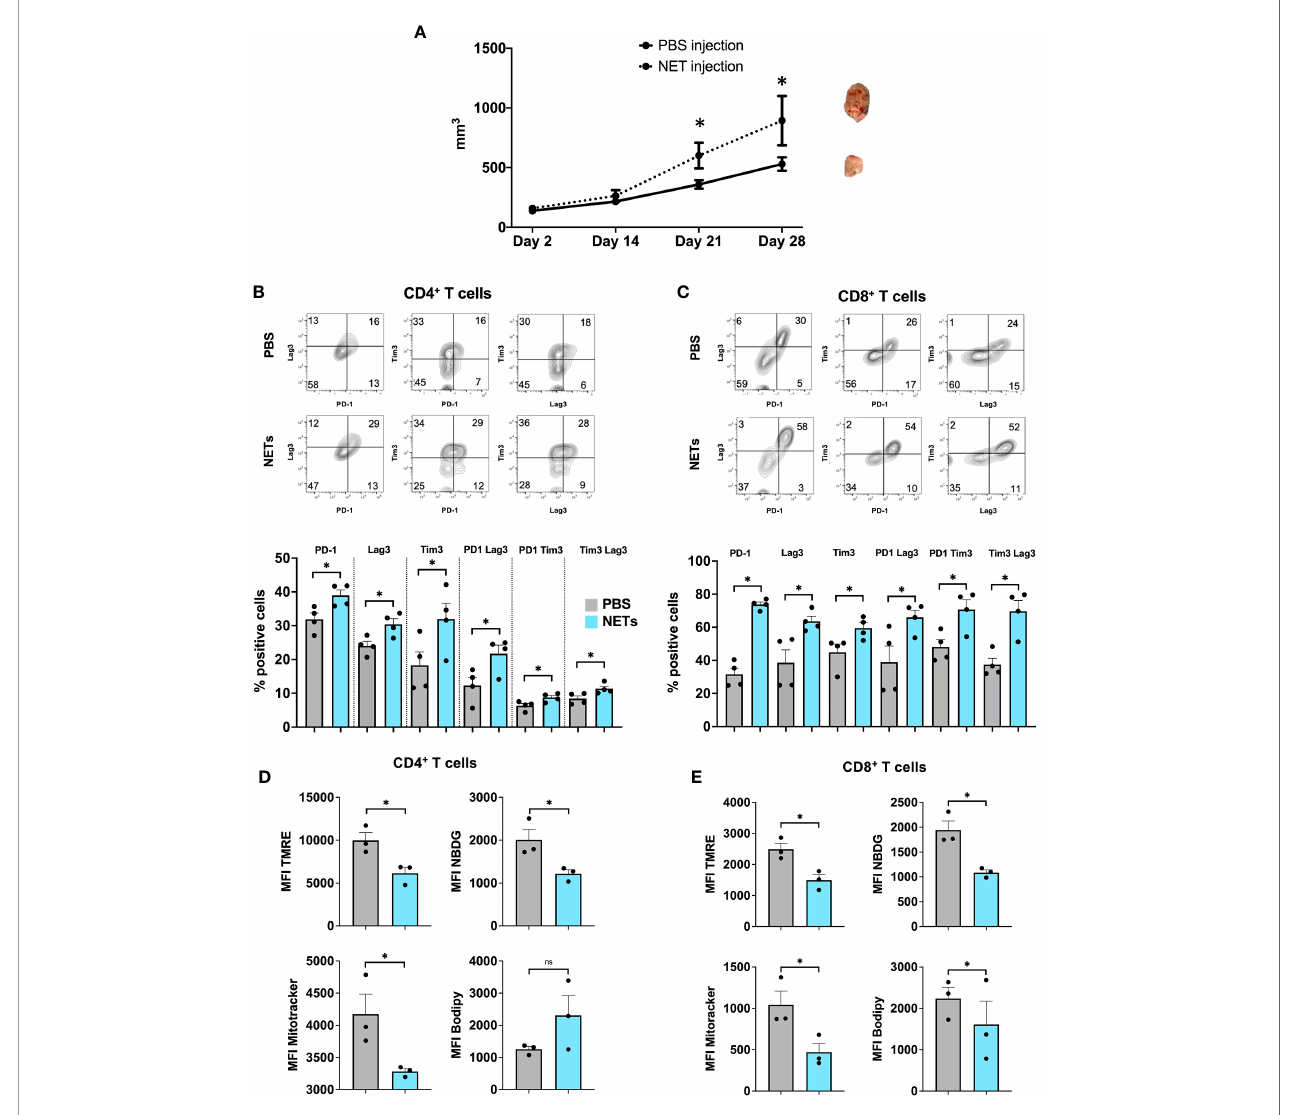
FIGURE 3 | Exogenous administration of NETs leads to enhanced T cell exhaustion in the TME. (A) 8-week-old B6 mice underwent subcutaneous injection of MC38 cancer cells in addition to biweekly NETs or PBS, respectively. Mice following NET injection had larger tumors at 3-4 weeks. (B, C) Markers for T cell exhaustion were analyzed by fl ow cytometry, these markers were signi fi cantly upregulated on T cells in tumors that received additional injection or puri fi ed NET chromatin but not PBS. (D, E) Similarly, T cells in NET injected tumors showed decreased mitochondrial activity, decreased glucose but increased lipid uptake compared to PBS injected tumors. Bar graphs represent mean +/- SEM of two independent experiments, performed with 3 mice each. *p < 0.05, **p <